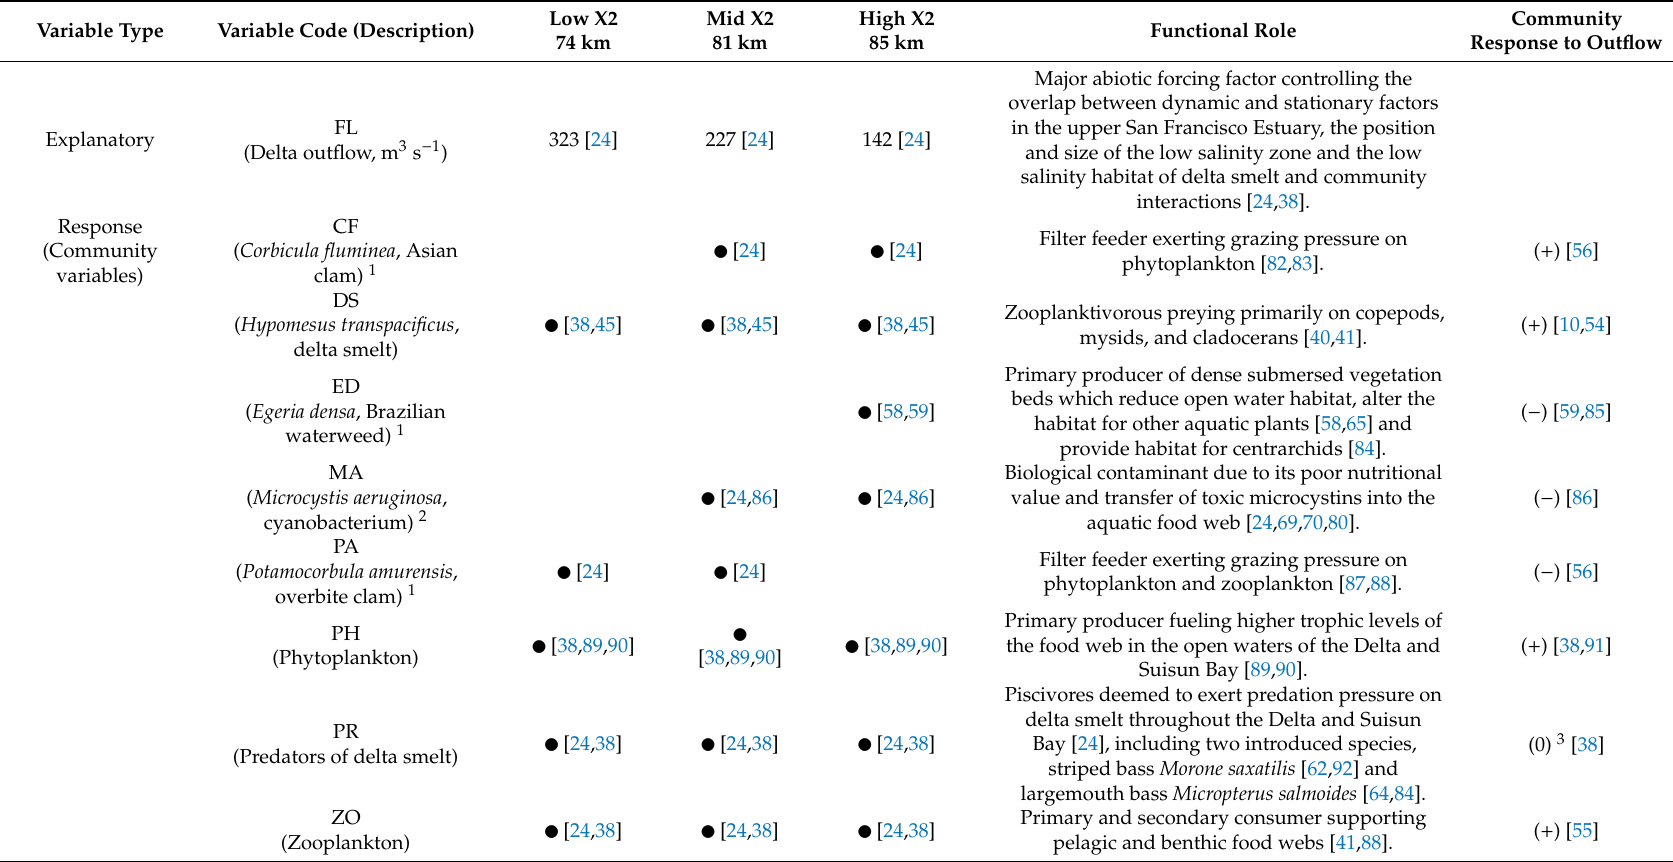
Table 1. Variables considered in qualitative community models for the upper San Francisco Estuary. Black circles denote community variables included in the low salinity zone at three positions of the 2 psu isohaline